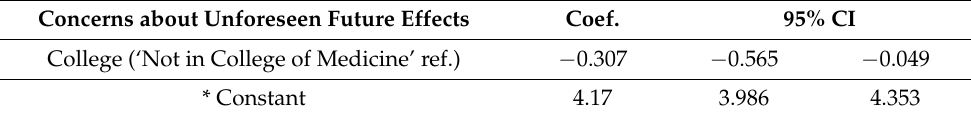
Table 4. Linear regression model of Expressed Concerns About Unforeseen Future Effects.